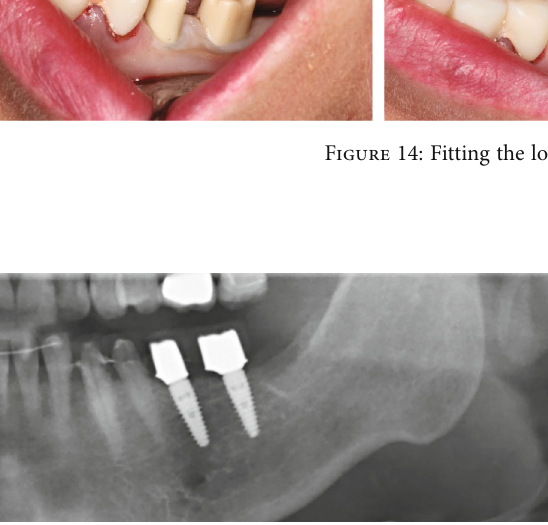
Figure 15: X-ray check during LTT fi tting.